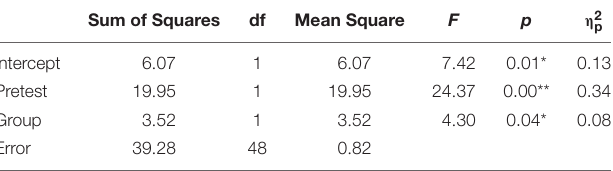
TABLE 3 | One-way ANCOVA on self-efficacy in creativity between two groups. Sum of Squares